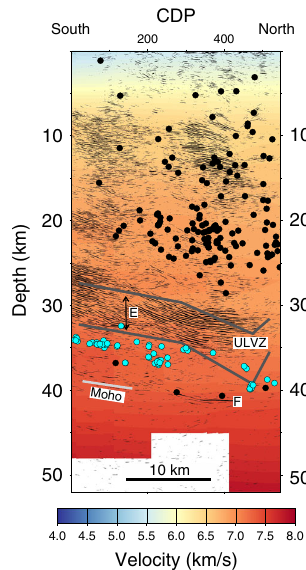
Fig. 3 Migrated seismic re fl ection pro fi le on Vancouver Island with superimposed P wave velocity model. The seismic pro fi le, 84-02, is shown by the brown line in Fig. 1. Low-frequency earthquakes ( fi lled blue circles) occur 0 – 3 km below the base of the landward dipping E re fl ectors. P wave velocity increases with depth reaching ~7 km s − 1 within the E re fl ections, which are ~6 km thick here. A steeply dipping crustal fault that extends from the surface near CDP (Common Depth Point) 150 to its truncation by the E re fl ectors at ~30 km depth near CDP 400 has been interpreted from the distribution of crustal seismicity 68 . Filled black circles — earthquakes relocated during 3D tomographic inversion; solid dark grey lines — top and bottom of ultra-low S wave velocity zone (ULVZ) projected from POLARIS (Portable Observatories for Lithospheric Analysis and Research Investigating Seismicity) pro fi le; solid light grey line — Moho of the oceanic plate where it is constrained by wide-angle P wave re fl ections in a previous 3D tomography study 64 . There is no vertical